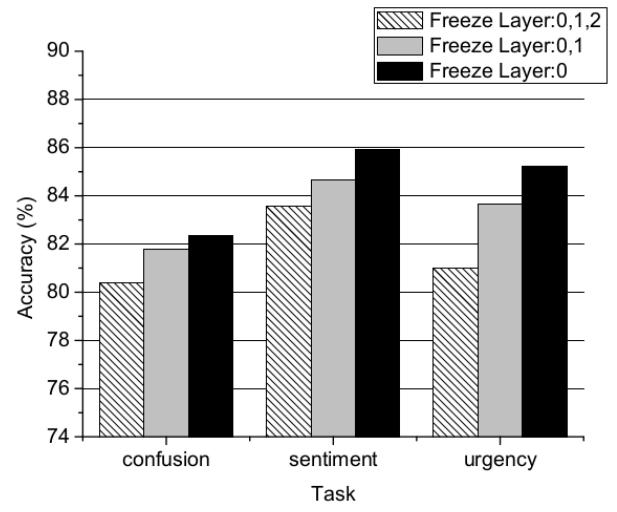
Figure 4. Comparison of the accuracy of ConvL when different layers are frozen.